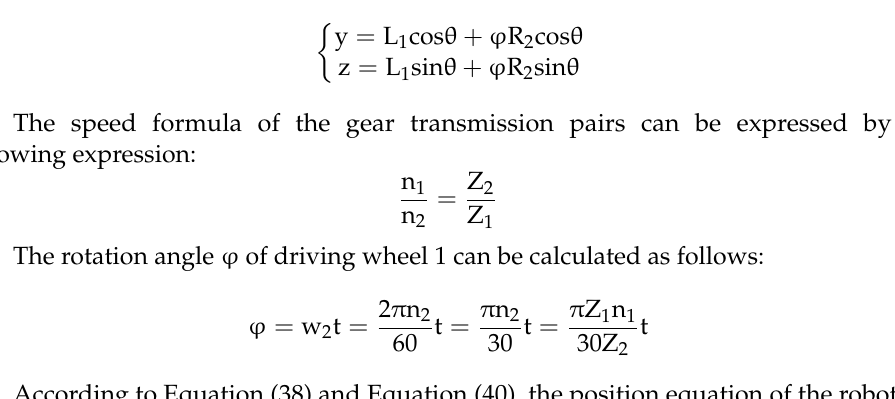
Figure 8. Schematic diagram of the kinematics analysis of the robot. In Figure 8, L 1 is the initial position length of the robot on the wire rope, v refers to the climbing speed of the robot, n 1 is the rotation speed of the motor, n 2 is the rotation speed of the driving wheel, Z 1 denotes the number of teeth of gear 1, Z 2 is the number of teeth of gear 2, w 1 represents the rotational angular velocity of the motor, w 2 is the rotational angular velocity of the driving wheel, φ stands for the rotational angle of the driving wheel, and θ is the angle between the axle of the wire rope and the Y direction of the inertial coordinate system. The position equation of the robot can be expressed by Equation